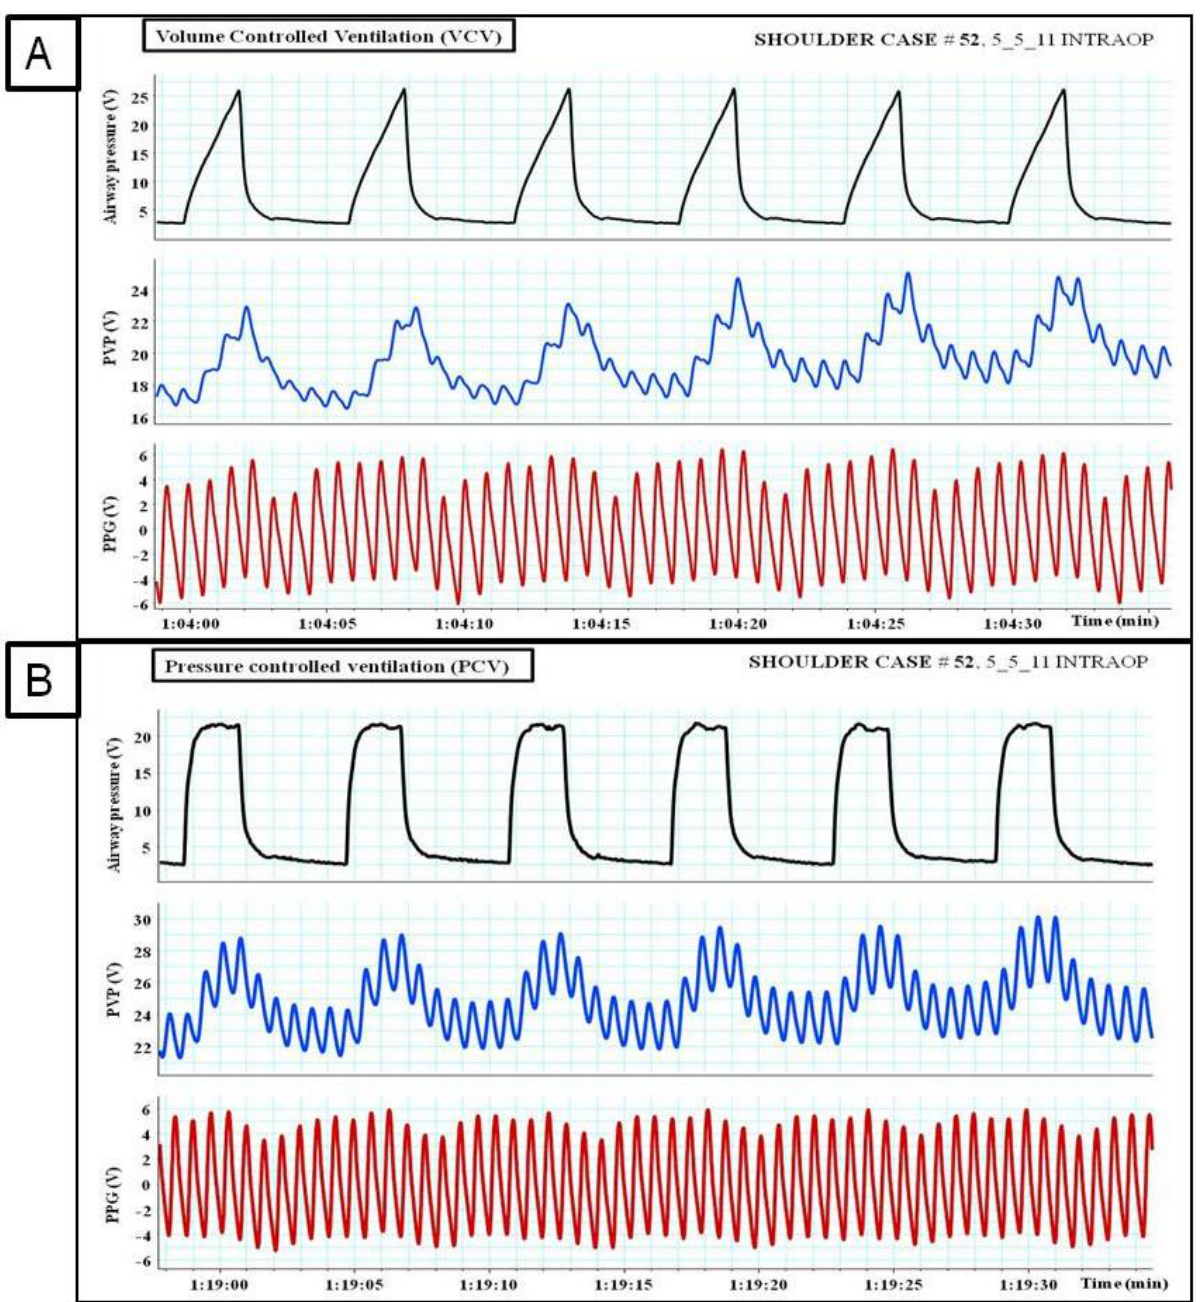
Figure 9. ( A ) The impact of volume controlled ventilation (VCV) and ( B ) pressure controlled ventilation (PCV) on peripheral venous pressure (PVP) and plethysmographic (PPG)